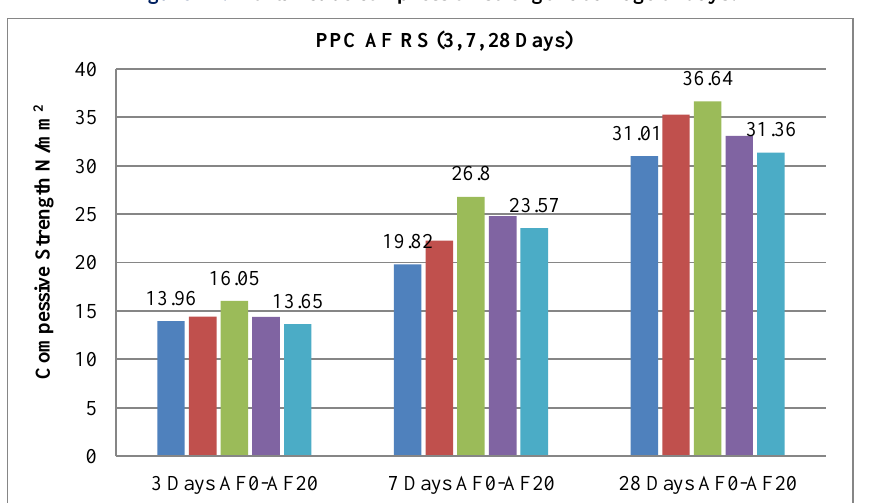
Figure 17. Mortar cube compression strength at all age of days.